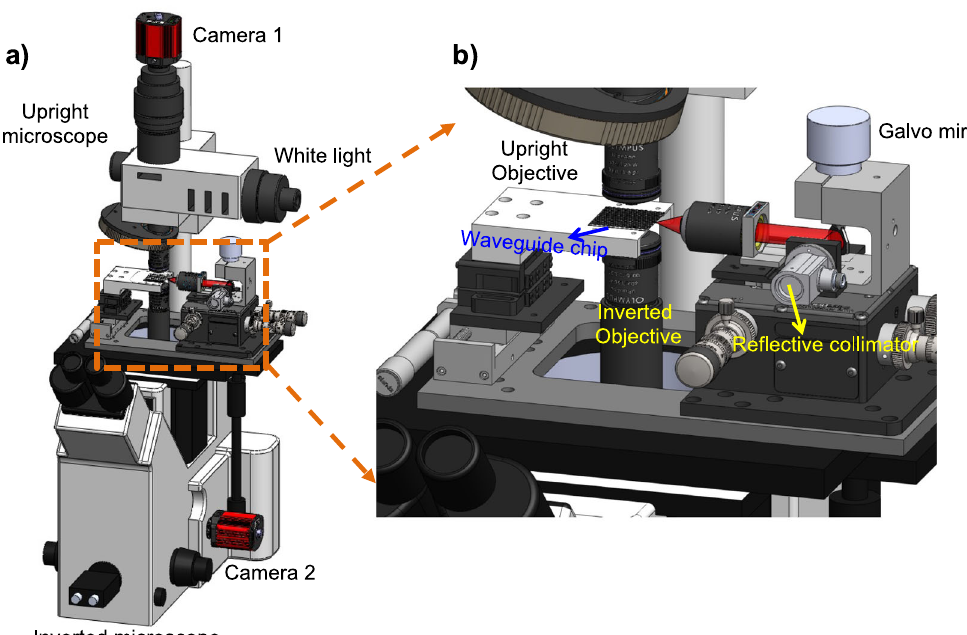
Fig. 3 3D view of the dual-con fi guration microscope used for c-TIRF imaging. a 3D rendering of the integrated c-TIRF microscope, where the upright